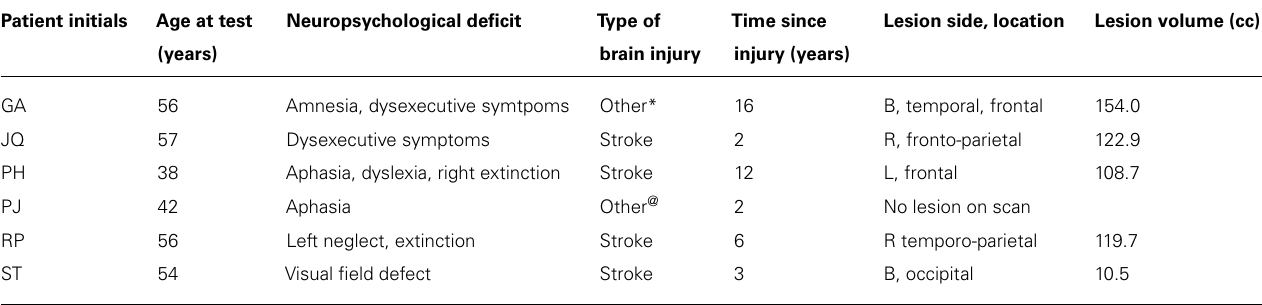
Table 1 | Control patients with their associated ages, gender and lesion